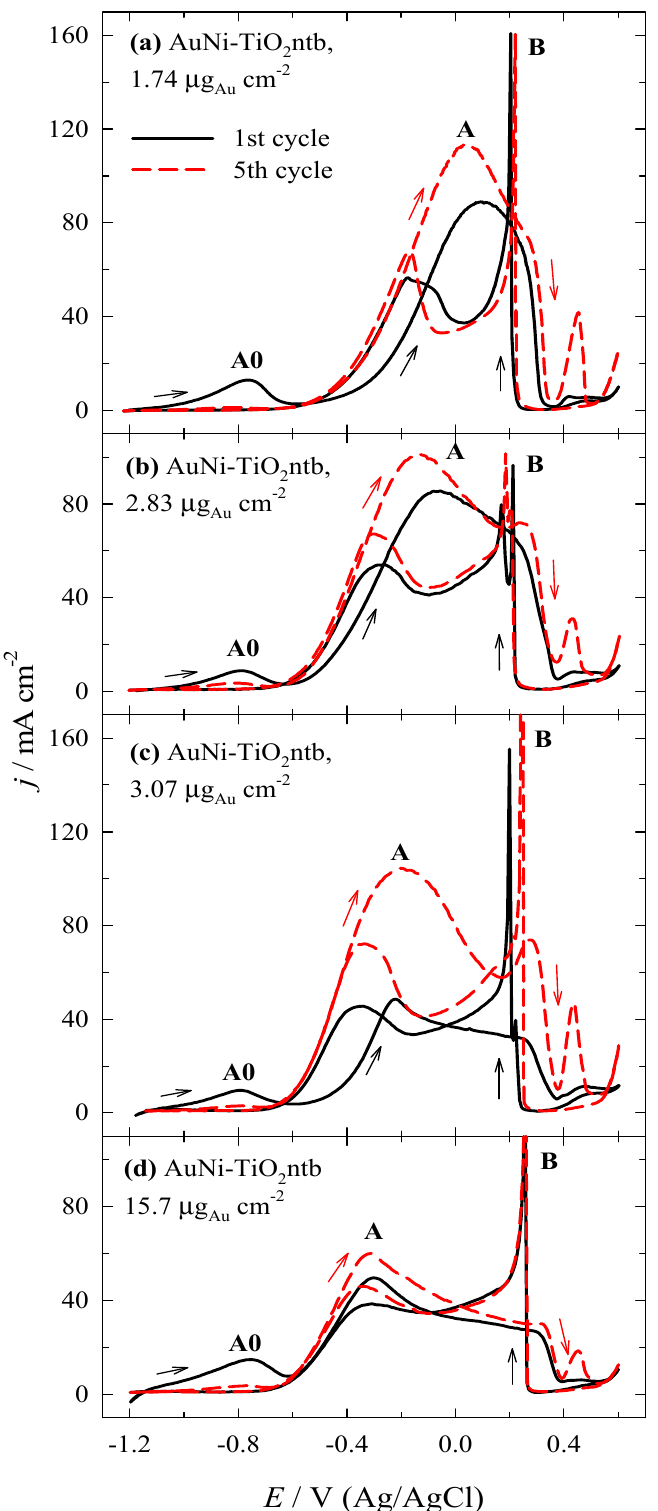
Figure 7. CVs were recorded on the different AuNi-TiO 2 ntb catalysts in a 0.05 M NaBH 4 + 1 M NaOH solution at 25 ◦ C at 10 mV · s − 1 . AuNi-TiO 2 ntbs were fabricated by the dipping of TiO 2 ntb in the Ni plating solution operated at 85 ◦ C for 60 s, followed by their dipping in the Au plating solution for time (s): ( a ) 10, ( b ) 20, ( c ) 60, and ( d ) 300.